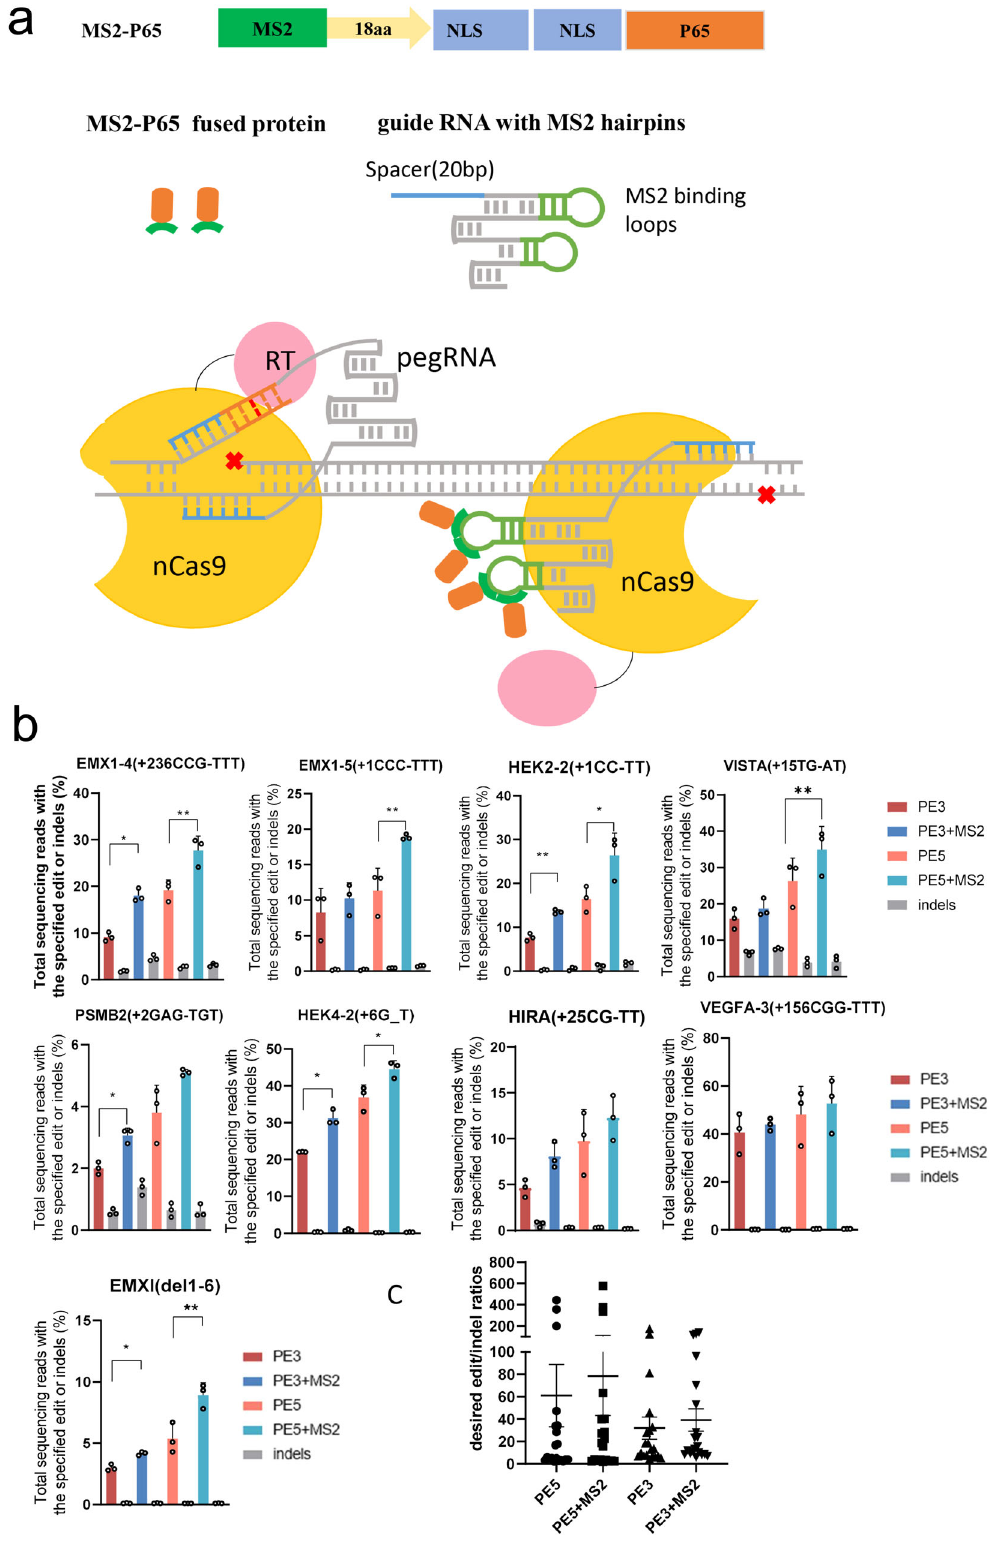
Fig. 3 | Editing ef fi ciency of the PE3 and PE5 systems upon recruitment of P65 through the MS2 system. a Diagrams of the MS2-P65 fusion protein constructs and an overview of the MS2-P65-recruiting PE3 or PE5 (PE3+MLH1dn) system. b Prime editing of genomic DNA in HEK293T cells by the MS2-P65-recruiting PE3 and PE5 systems. The editing ef fi ciencies re fl ect the sequencing reads that con- tainedtheintendededitsanddidnotcontainindelsamongalltreatedcells,withno sorting. The gray bar indicates the indel frequency coupled with the editing